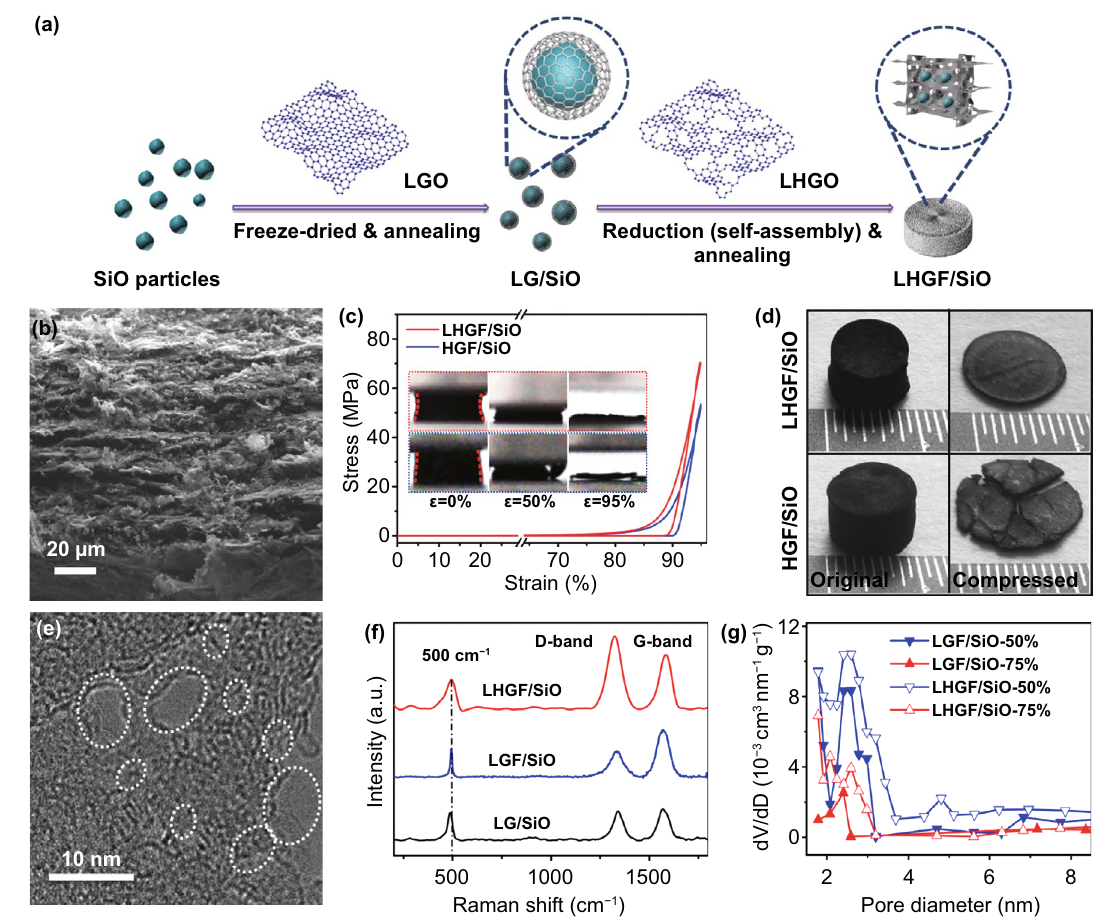
Fig. 1 Illustration of the two-step process flow to prepare 3D hierarchically porous composite architecture and structural characterization of LHGF/SiO composite. a Illustration of preparation process of LHGF/SiO composite. b Cross-sectional SEM image of the compressed 3D com- posite. c Uniaxial compression of LHGF/SiO and HGF/SiO with strain up to 95%. Inset: experimental snapshots of the LHGF/SiO and HGF/ SiO composite during uniaxial compression. d The photograph showing corresponding structure before and after mechanical compression (95% stress). e TEM image of graphene sheet with tailored pores. f Raman spectra of LHGF/SiO, LGF/SiO and LG/SiO composites. g Comparison of BJH pore size distribution for LHGF/SiO and LGF/SiO